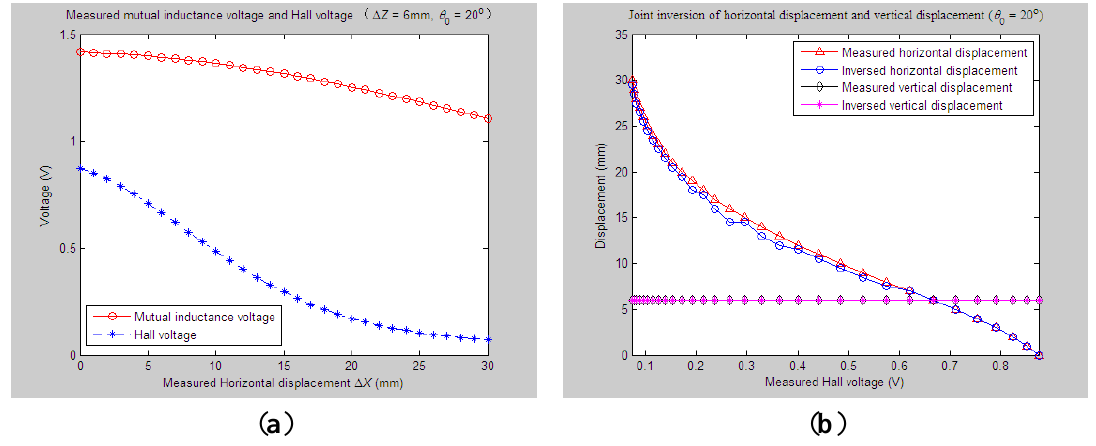
Figure 9. Horizontal and vertical displacement joint inversion results when measured Δ X are changed, while measured Δ Z remain stable ( θ 0 = 20°, Δ Z = 6 mm). ( a ) Measured mutual inductance voltage and Hall voltage; ( b ) inversed horizontal and vertical displacements.